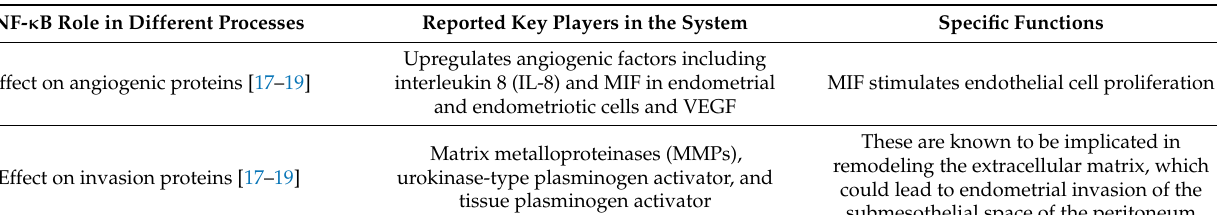
Table 1. Recent research indicating the impacts of NF- κ B on various mechanisms and the subsequent effects on endometrio- sis development.